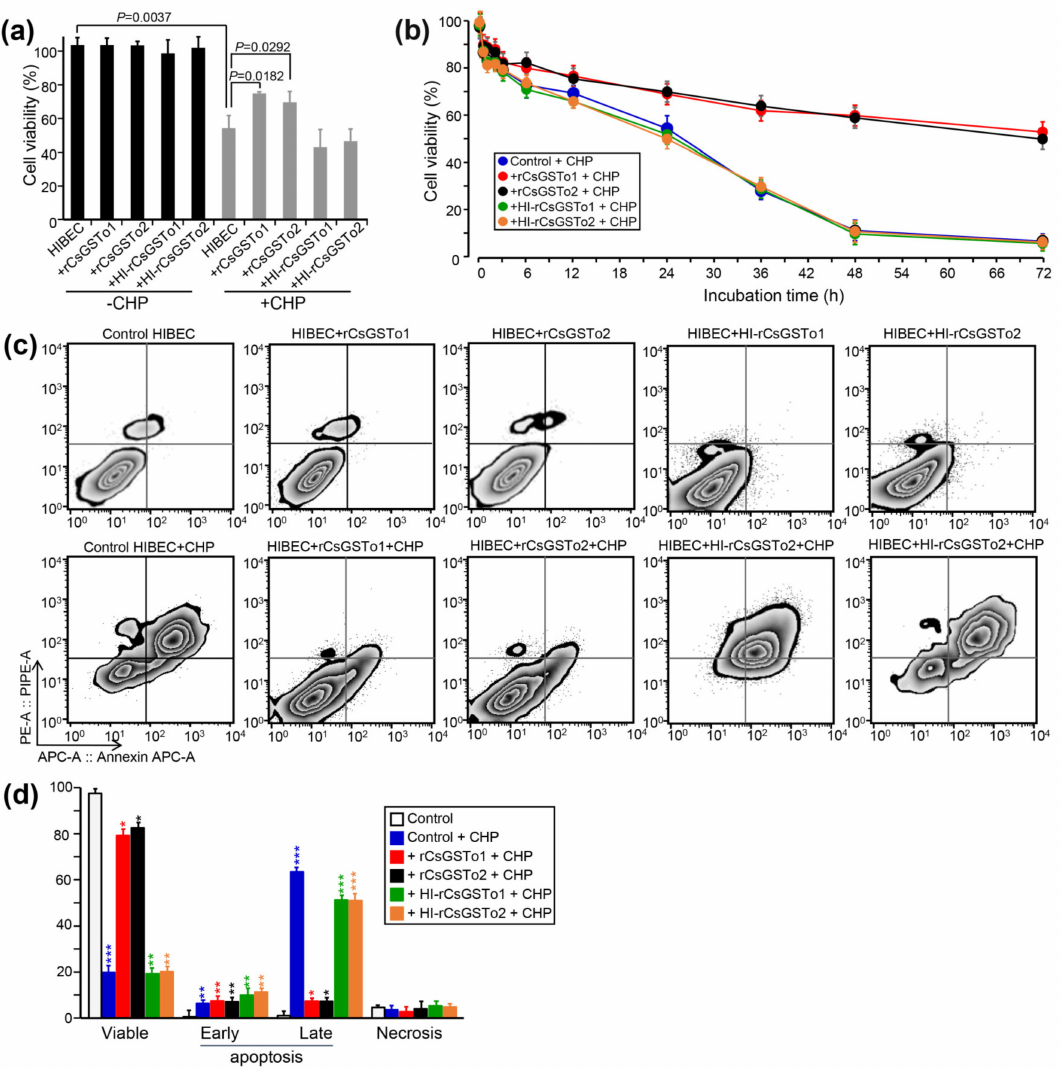
Figure 2. rCsGSTos potentiated cell survival through inhibition of oxidative stress-induced apoptosis. ( a ) Comparison of cell viability between rCsGSTos-incorporated HIBECs and control HIBECs. Control HIBECs and HIBECs introduced with either naïve rCsGSTos or heat-inactivated rCsGSTos were exposed to 150 µ M CHP for 24 h at 37 ◦ C in a 5% CO 2 incubator. Cell viability was spectrophotometrically detected. Mean ± SD ( n = 6). ( b ) Control and rCsGSTos-incorporated HIBECs were cultured for different time intervals in the presence of 150 µ M CHP. HIBECs incorporated with heat-inactivated rCsGSTos were also assayed. Mean ± SD ( n = 3) * p < 0.05, ** p < 0.01, *** p < 0.001. ( c ) rCsGSTos significantly rescued human cholangiocyte from oxidative stress-induced apoptosis. HIBECs introduced with either naïve rCsGSTos or heat-inactivated rCsGSTos were incubated for 24 h in the presence of 150 µ M CHP. Apoptosis rates were analyzed by FACS. The cells were stained with annexin V (Annexin APC-A) and propidium iodide (PE-A). ( d ) Statistical analysis of early and late apoptosis rates, and necrosis in control and rCsGSTos-incorporated HIBECs. Mean ± SD ( n = 3). * p < 0.05, ** p < 0.01, *** p <